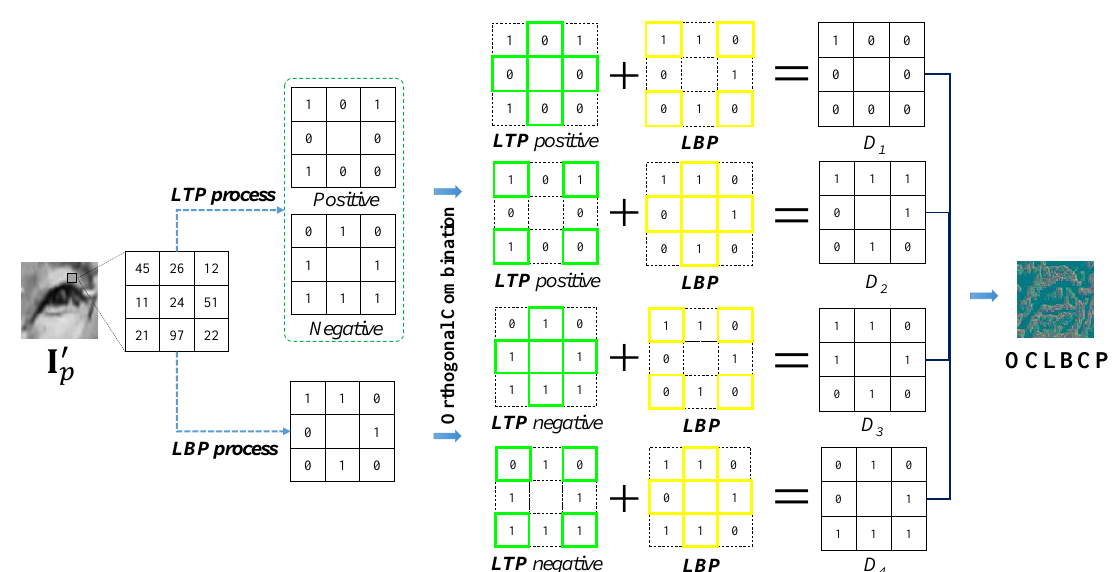
Figure 2. Illustration of Orthogonal Combination–Local Binary Coded Pattern